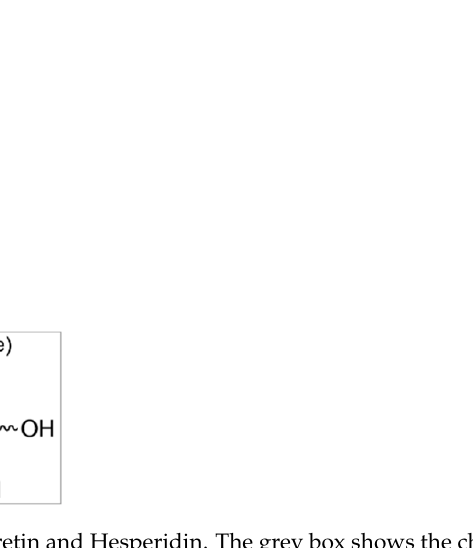
Figure 1. The chemical structures of Hesperetin and Hesperidin. The grey box shows the chemical structure of Rutinose.